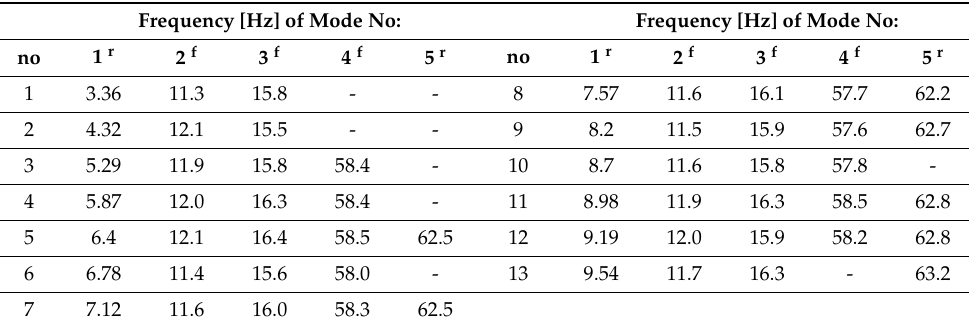
Table 4. First five natural frequencies for 13 prestress levels.